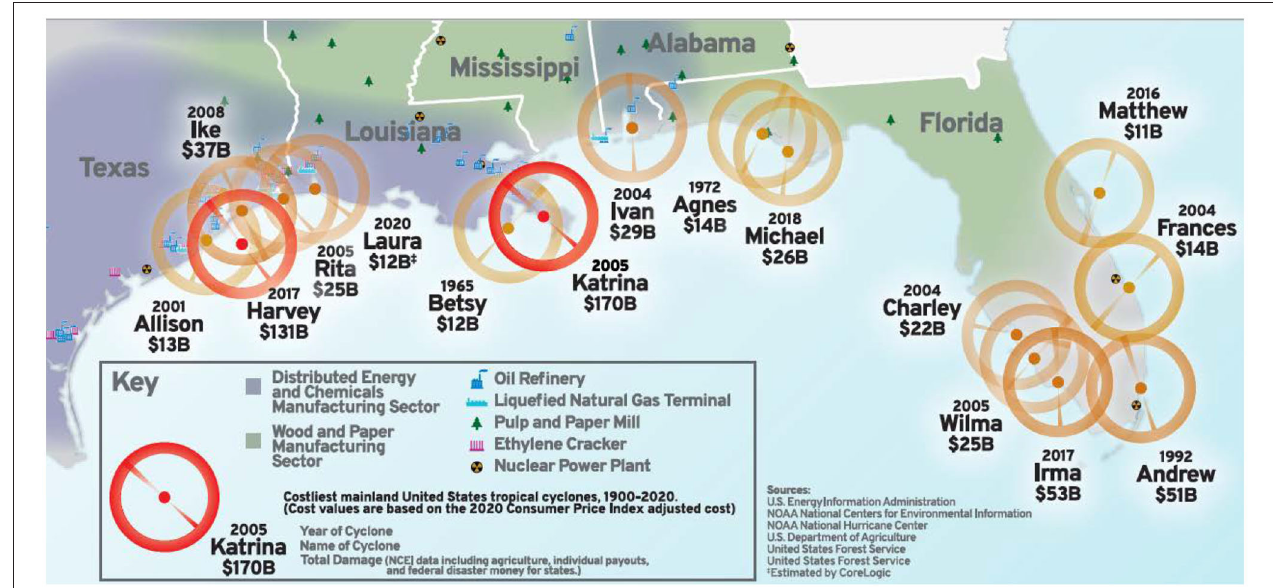
FIGURE 1 | Hurricane damages and major industries in the US Gulf Coast Region.